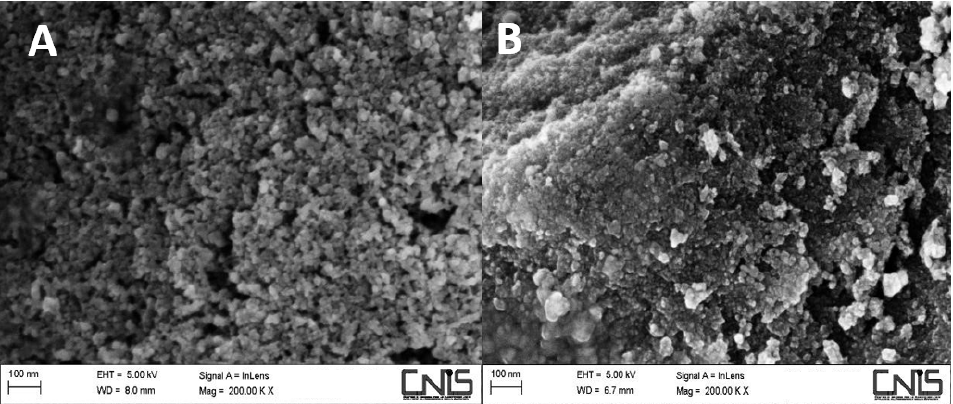
Figure 1. SEM micrographs: ( A ) naked MNPs; and ( B ) MNPs coated with CS during their formation (MNPs-CS in situ ).